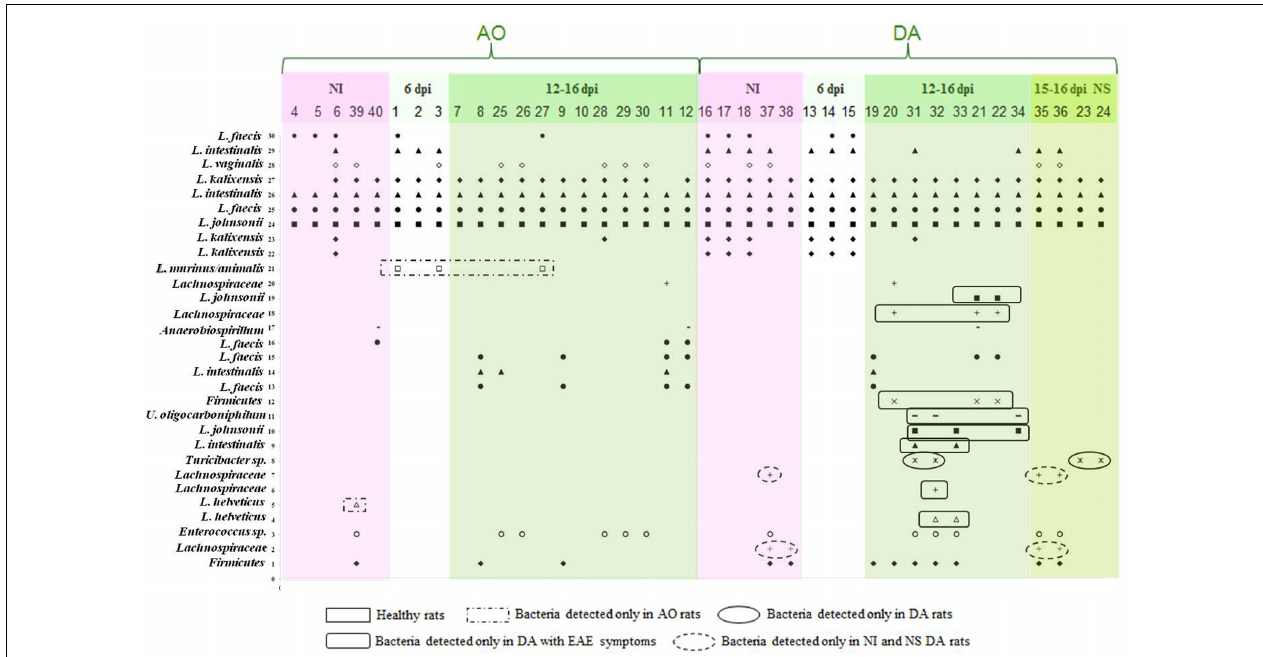
FIGURE 2 | The identity of the rDNA clones obtained from DGGE bands related to the rats and the period of EAE induction. The numbers on the y -axis (1–30) correlate with the numbers of the bands excised, cloned, and sequenced, while the numbers on the x -axis correspond to the numbers of lanes as presented in Figure 1 . Each lane represents sample of an individual rat. Total of 40 samples (20 from each of the strains) was analyzed. Five samples were collected before the immunization (non-immunized rats – NI), three samples were collected at 6 d.p.i., and 12 samples were collected at 12–16 d.p.i., from each of the strains. There were four samples of DA rats that had no clinical symptoms of EAE